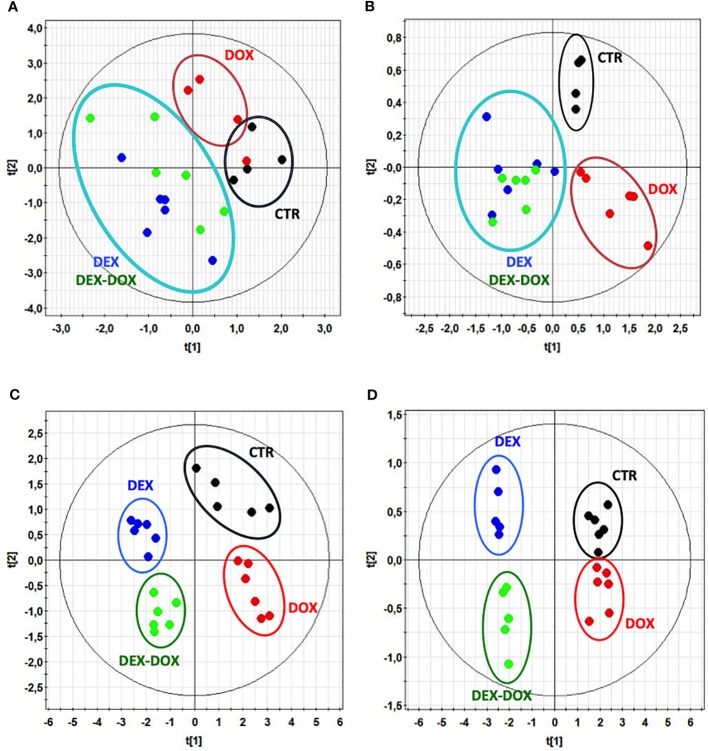
Scores plots of PLS-modeled metabonomic data: control group (•) vs DOX group (•) vs DEX group (•) vs DEX-DOX group (•). (A) Intracellular extracts of 4 hours exposure. R2
cum = 0.36; Q2
cum = 0.04; Hotteling's T2 = 0.95; p-value (CV-ANOVA) > 0.05. (B) Culture media of 4 hours exposure. R2
cum = 0.69; Q2
cum = 0.45; Hotteling's T2 = 0.95; p-value (CV-ANOVA) < 0.05. (C) Intracellular extracts of 24 hours exposure. R2
cum = 0.59; Q2
cum = 0.54; Hotteling's T2 = 0.95; p-value (CV-ANOVA) < 0.05. (D) Culture media of 24 hours exposure. R2
cum = 0.59; Q2
cum = 0.52; Hotteling's T2 = 0.95; p-value (CV-ANOVA) < 0.05.